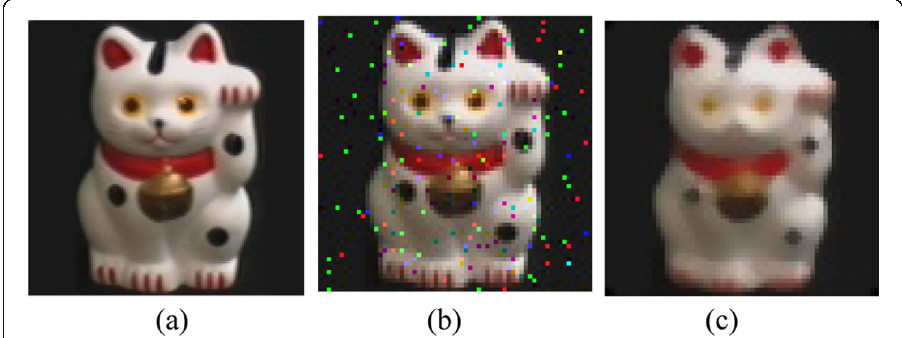
Fig. 5 The original and processed color images: a the original color image, b the image infected with 2% salt and pepper noise, and c the color image after smoothing through a filter with a 5 × 5